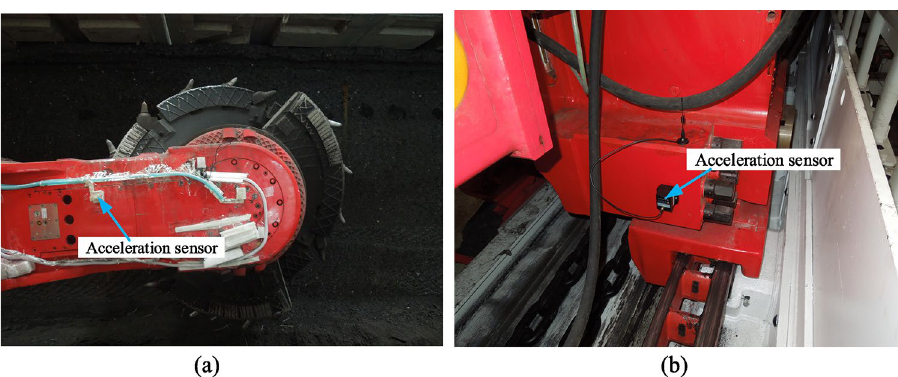
Figure 13. Ranging arm and walking unit vibration acceleration sensor mounting position: ( a ) ranging arm sensor arrangement, ( b ) walking unit sensor